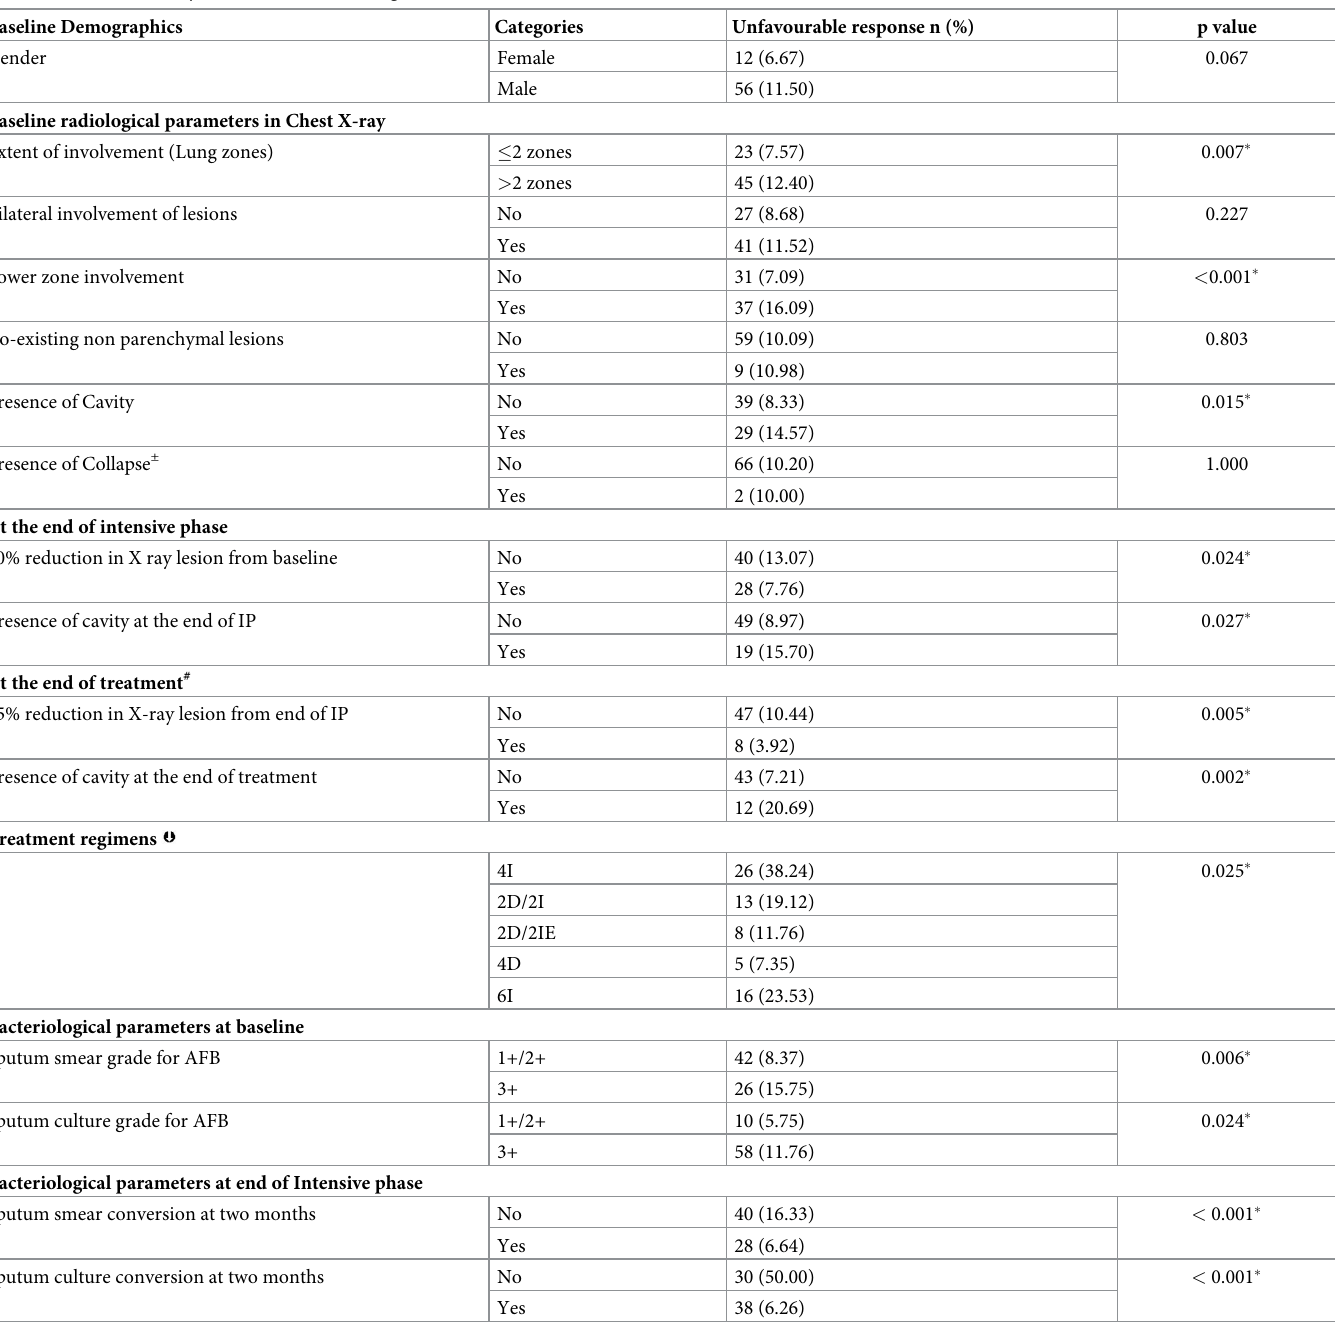
Table 2. Univariate analysis of factors influencing TB Treatment